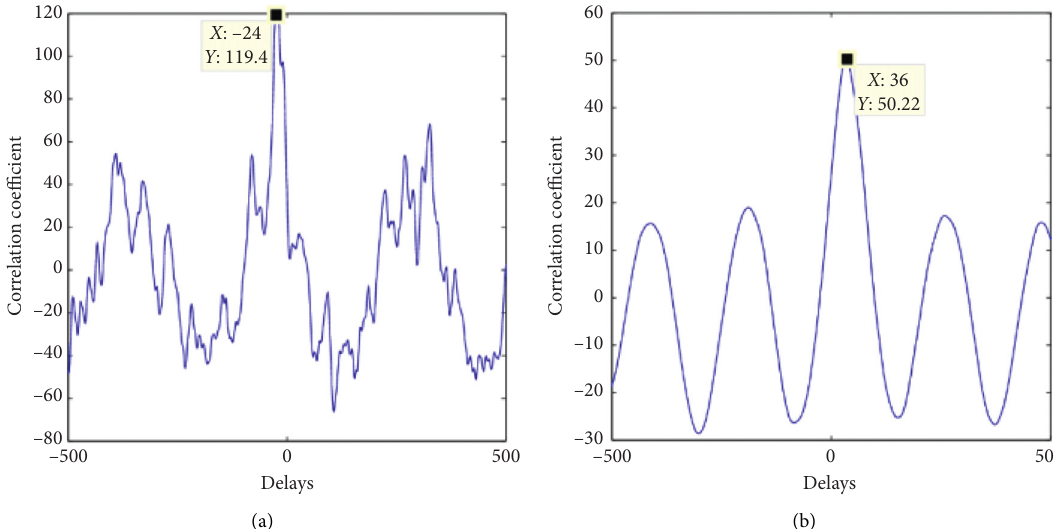
Figure 5: Peak search of the crosscorrelation coefficient: (a) the time delay of the maximal crosscorrelation D > 0 and (b) the time delay of the maximal crosscorrelation D <